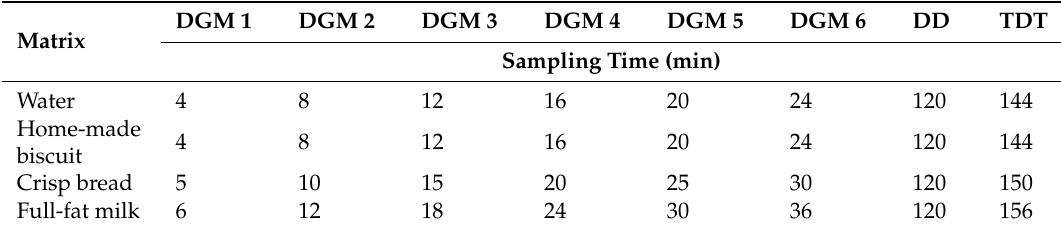
Table 1. Simulated human digestion